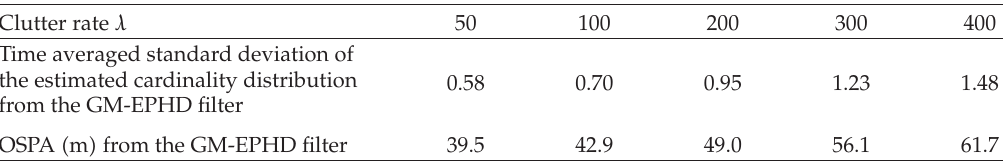
Table 1: Time averaged standard deviation of the estimated cardinality distribution and time averaged OSPA (cid:2) m (cid:3) from the GM-EPHD filter in various J given λ (cid:8) 50. Gaussian number J in the mixture 50 100 500 700 Time averaged standard deviation of the estimated cardinality distribution from the GM-EPHD filter